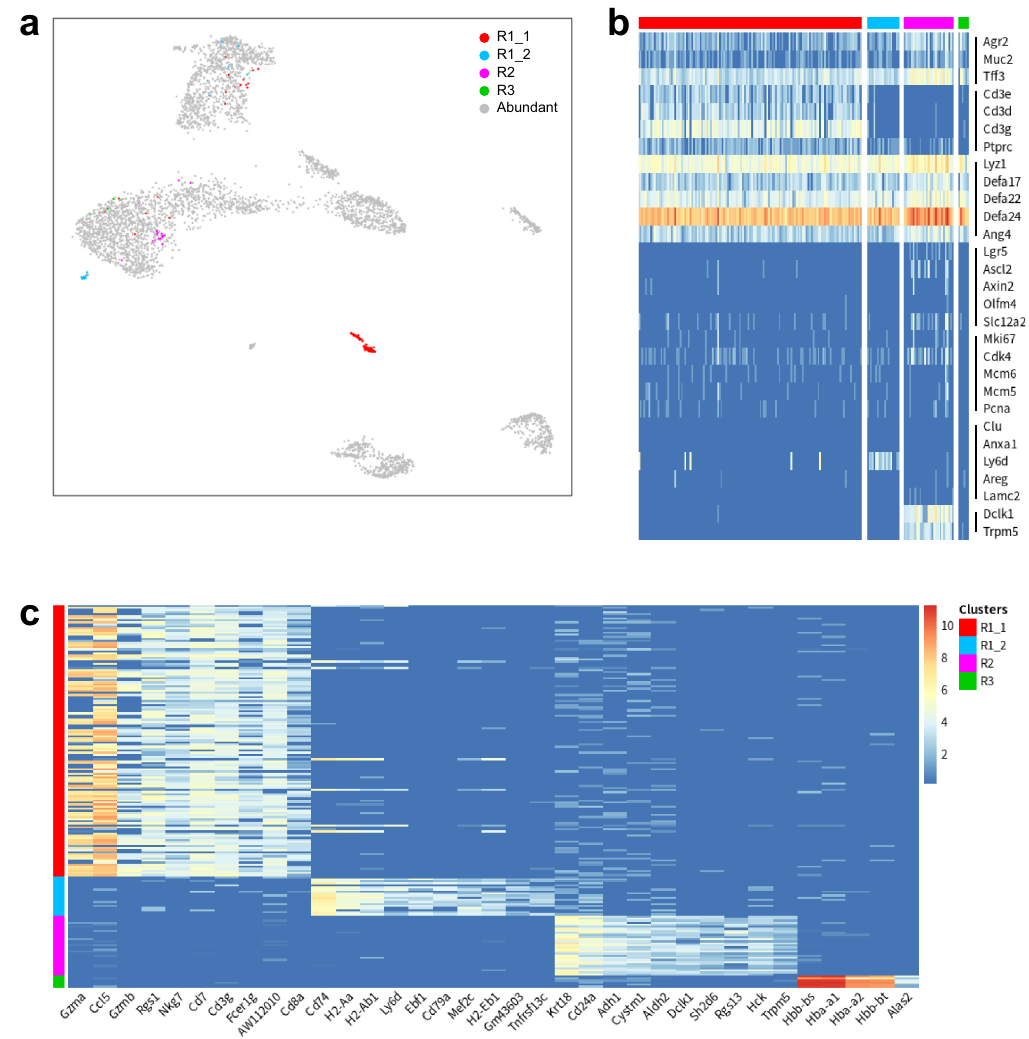
Fig. 5 Analysis of the intestine dataset. a The two-dimensional embeddings learnt by EDGE on the intestine dataset with rare cell types labeled in different colours. b Expression of differentiated lineage marker genes across all rare cell types. Note that marker genes ( Dclk1 , Trpm5 ) of tuft cells reported by Arshad et al. 29 are enriched in cluster R2. c Heatmap of top differentially expressed genes for each minor cluster. The same colour-coding scheme is used in all